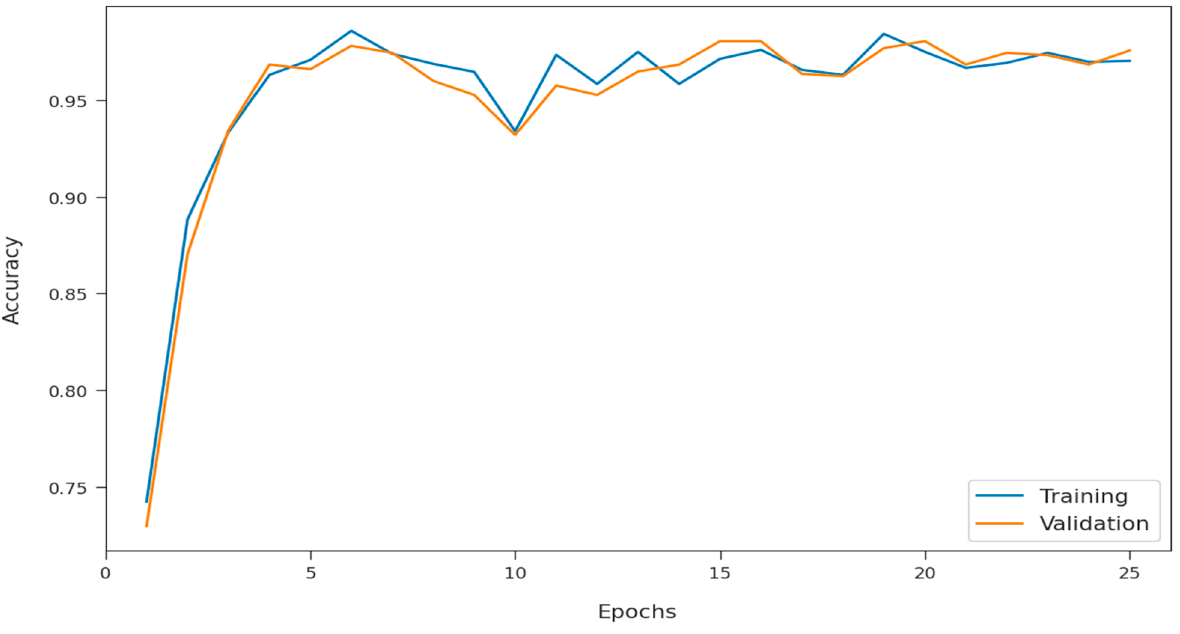
Figure 11. TA and VA analyses of SFODLD-SAC technique.